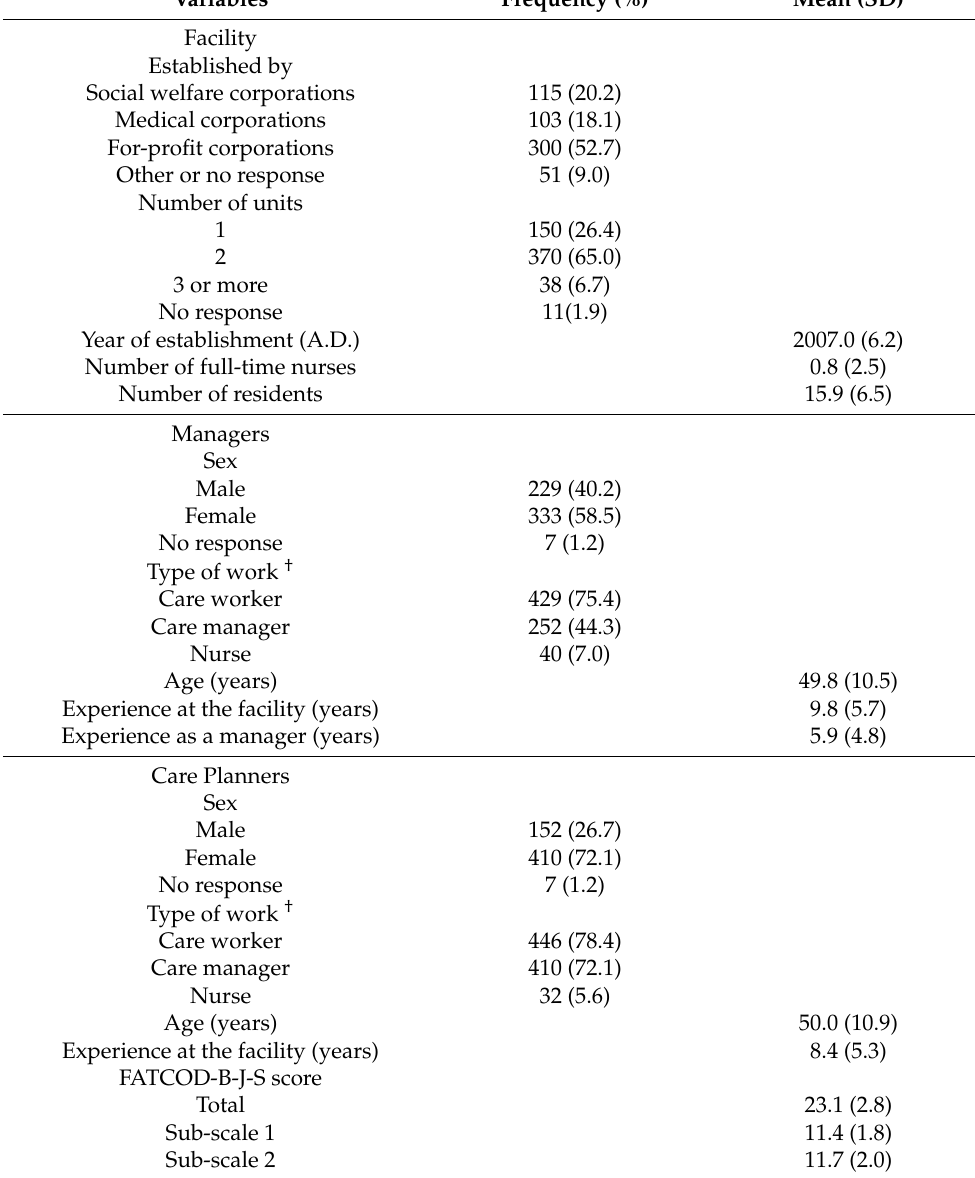
Table 1. Characteristics of the facilities, managers, and care planners ( N =